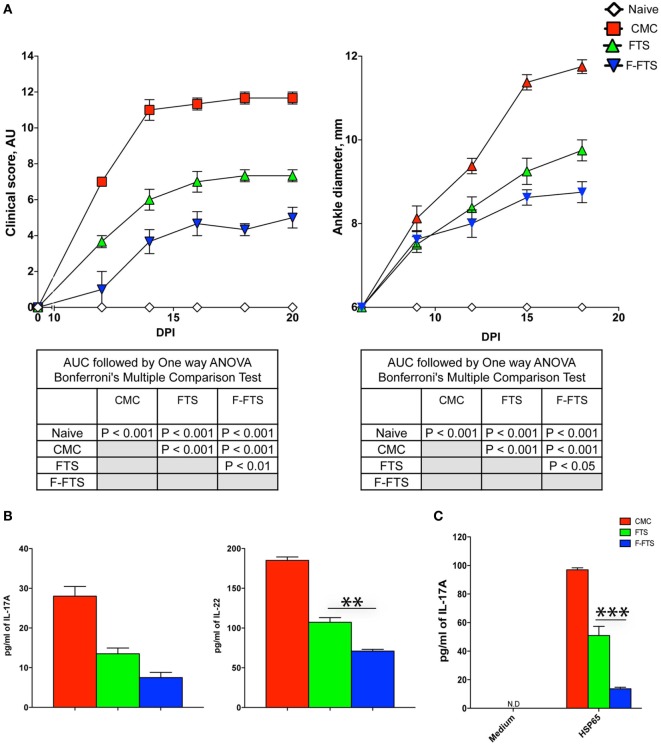
Fluoro-FTS (F-FTS) is significantly more effective than farnesylthiosalicylic acid (FTS) in attenuating multiple outcome measures of AIA. (A) Rats immunized with CFA were treated starting day +1 with either oral FTS (100 mg/kg), F-FTS (60 mg/kg), or 0.5% carboxymethyl cellulose (CMC) vehicle solution. Arthritis severity was graded by clinical scores (left panel) and ankle diameter (right panel). Statistical analysis of the AUC of the effect of the treatments on the clinical outcomes was done by one way ANOVA with post hoc Bonferroni’s multiple comparison test, and the results are summarized in the table insets. (B) Sera from rats treated with either CMC, FTS, or F-FTS (n = 5 per group) were collected at day +14 and analyzed for IL-17A and IL-22 levels by readymade ELISA kits. (C) In paralleled, single cell suspensions from draining LNs and spleen of the various rats were stimulated with Bhsp65 (5 µg/ml) of or vehicle and cultured for additional 72 h. At culture termination, we analyzed the supernatants for the levels of Bhsp65-induced 17A secretion by ELISA. One representative experiments out of two performed. Bar graphs depict mean ± SD. Statistical significance was assessed by the Student’s t-test (*P ≤ 0.05, **P ≤ 0.01, and ***P ≤ 0.001).